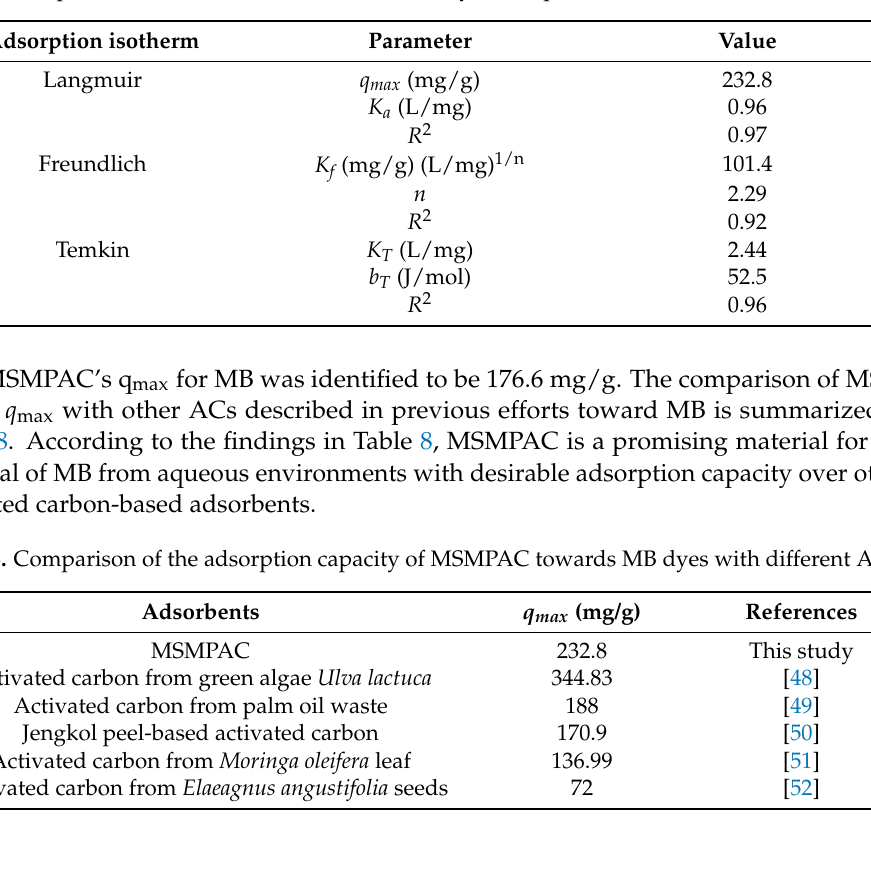
Table 7. The parameters of isotherm models for MB dye adsorption on MSMPAC.